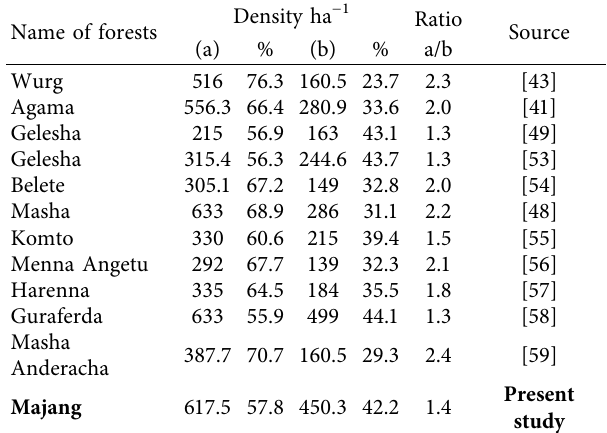
Table 15: Pearson correlation matrix in the density of seedlings, saplings, and tree stems ha − 1 . Variables